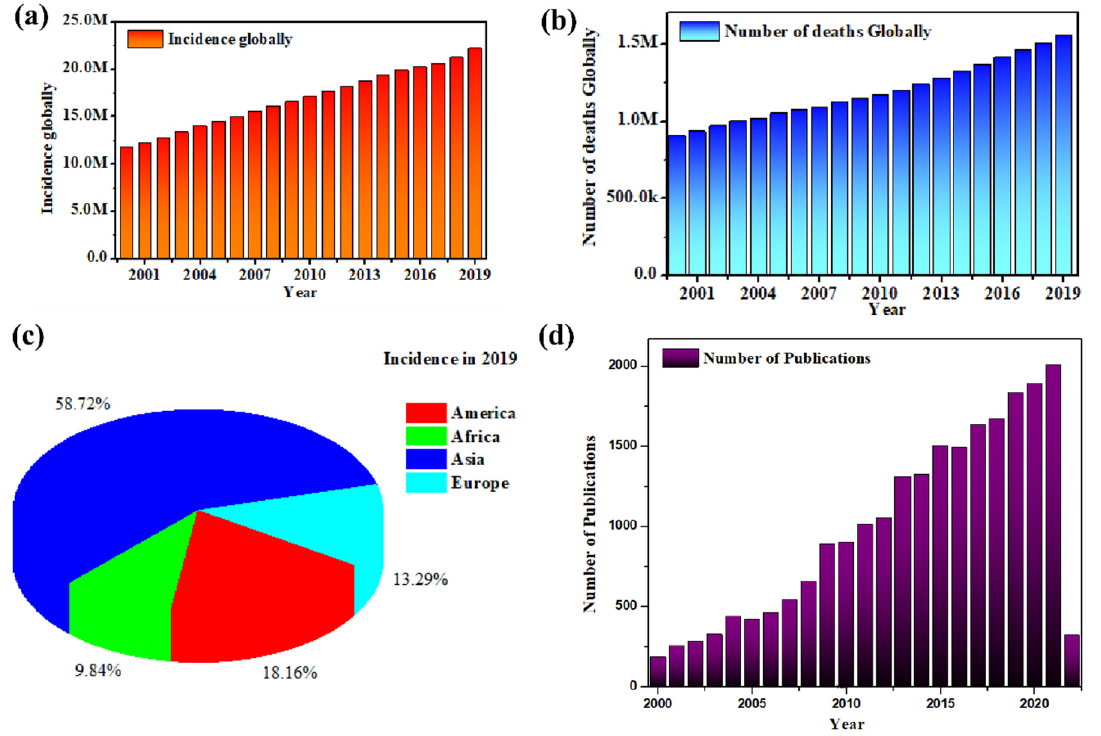
Figure 1. Statistical distribution of diabetic incidence around the world in recent decades. Global ( a ) incidence and ( b ) deaths since 2000. ( c ) Continent-wise distribution of diabetes incidence in 2019. Source: Global health database, February 2022. ( d ) Number of research articles published on various types of glucose sensors since 2000. Source: Scopus database, February 2022.